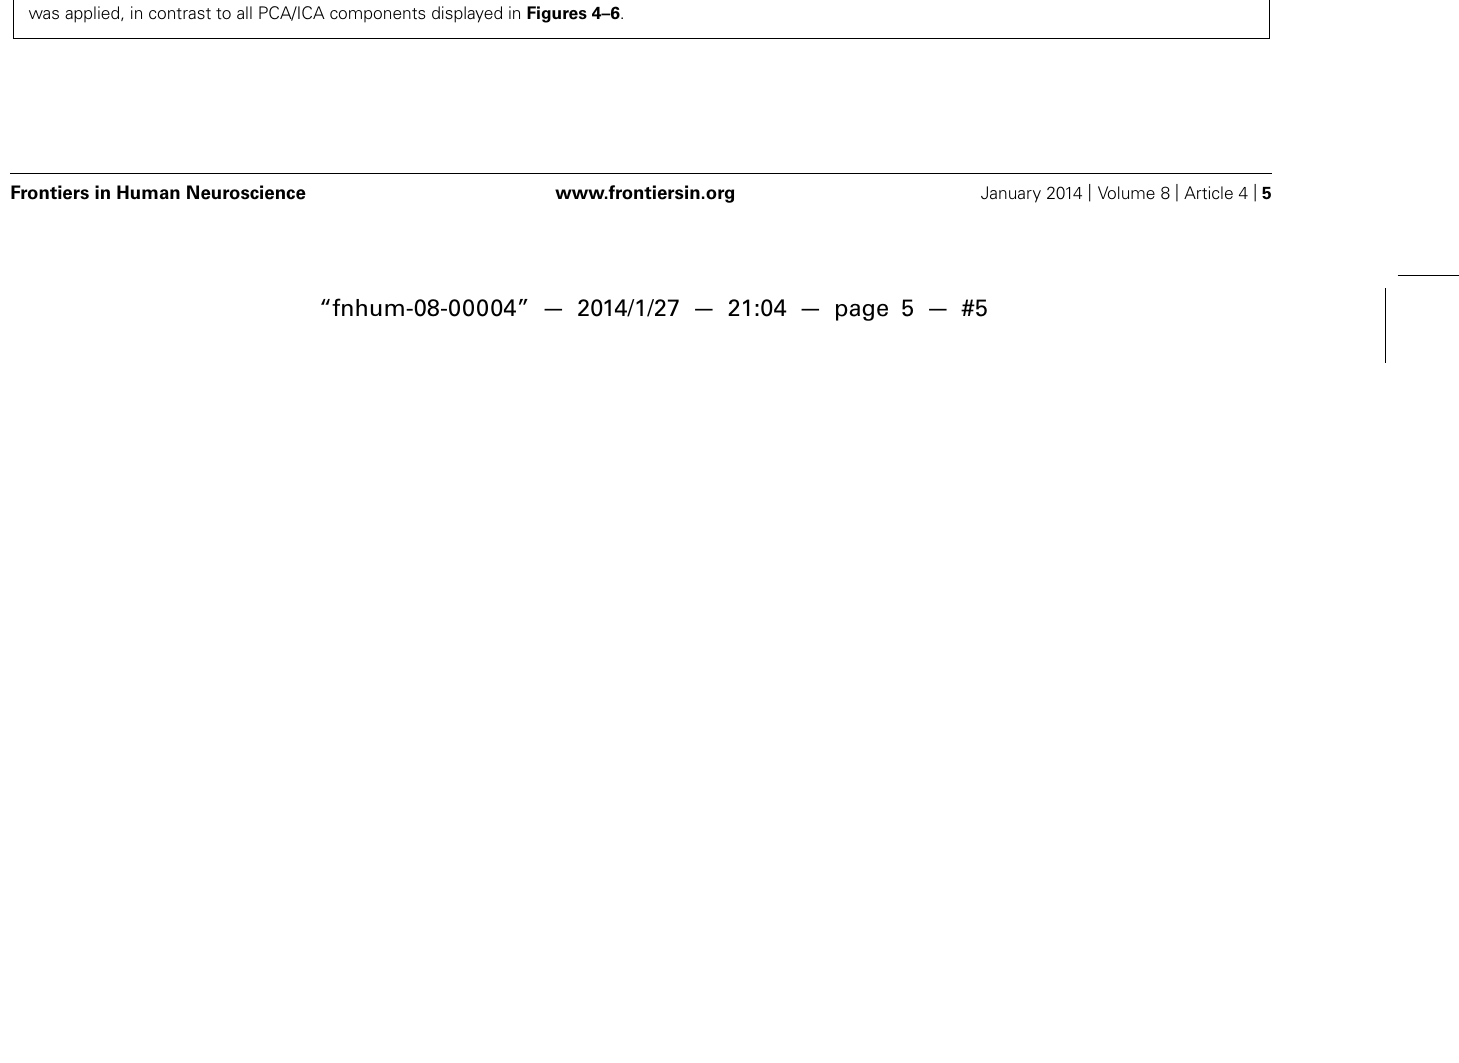
FIGURE 3 | Original grand-average ERP waveforms at FCz and Pz. Note that in this figure, a baseline correction (between − 200 ms and stimulus onset) was applied, in contrast to all PCA/ICA components displayed in Figures 4–6